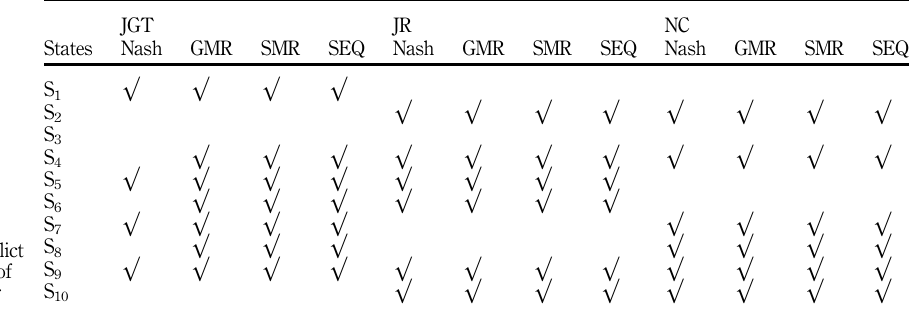
Table 3. The equilibrium solution of the conflict of the discharging of nuclear